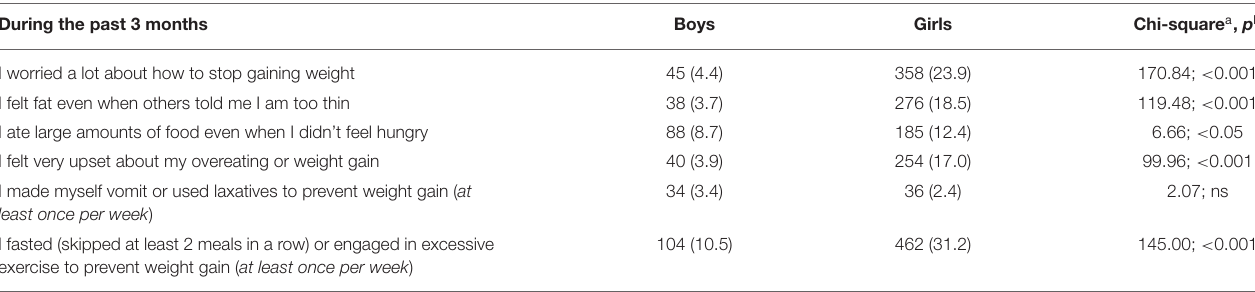
Prevalence described for “certainly true” responses, unless indicated otherwise. a Chi-square, The Chi-square test. b p, Significance value. ns,